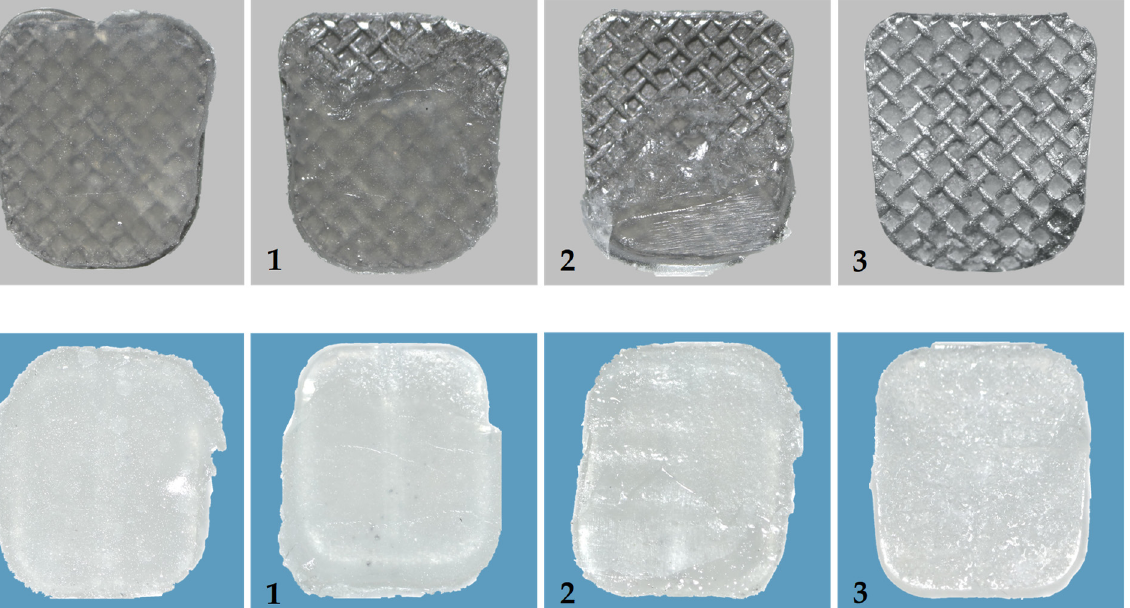
Figure 4. ( a ) Cross-sectional SEM image of the glazed monolithic zirconia attached to ceramic bracket (original magnification 27×, bar represents 500 μ m); ( b ) A, zirconia layer; B, adhesive layer; C, bracket base layer; black line, zirconia–adhesive interface; white line, bracket base–adhesive in- terface.